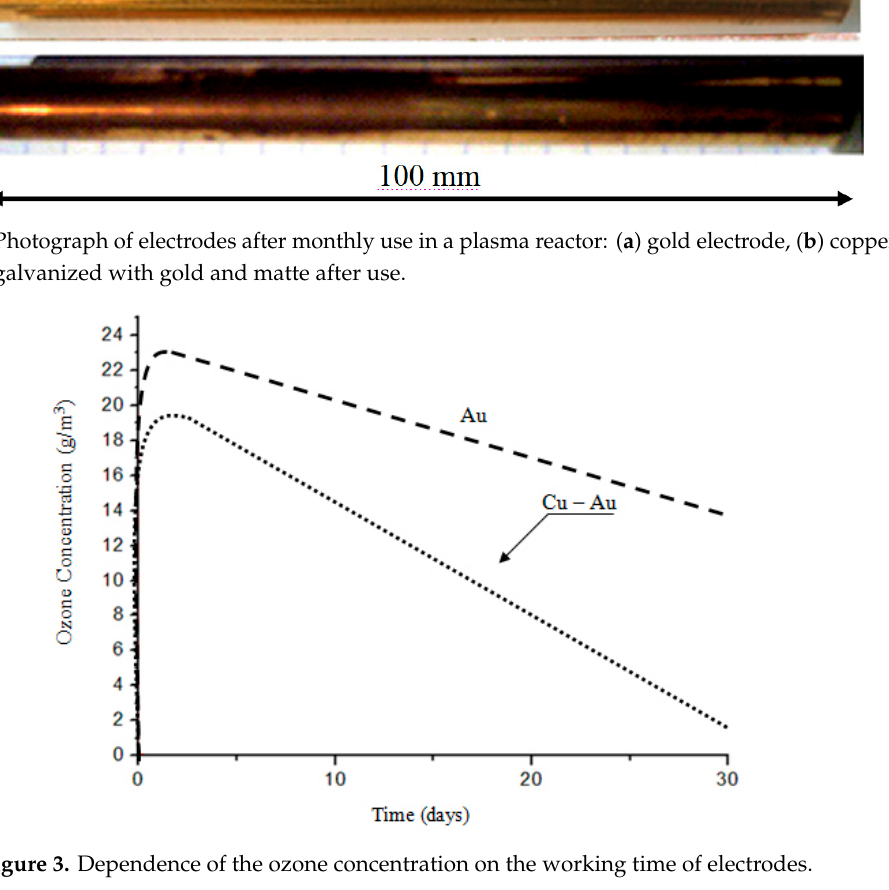
Figure 3. Dependence of the ozone concentration on the working time of electrodes.